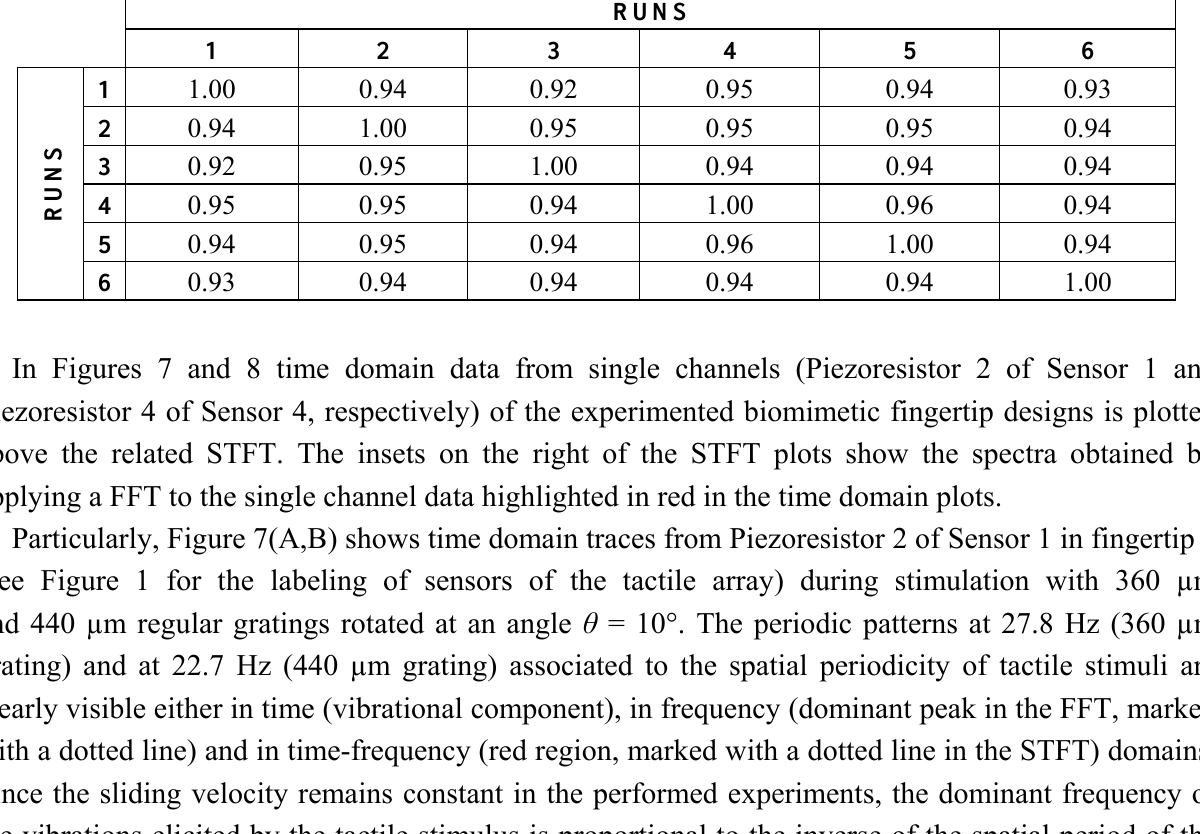
Table 1. Correlation indexes for all the pairs of experimental runs shown in Figure 6.